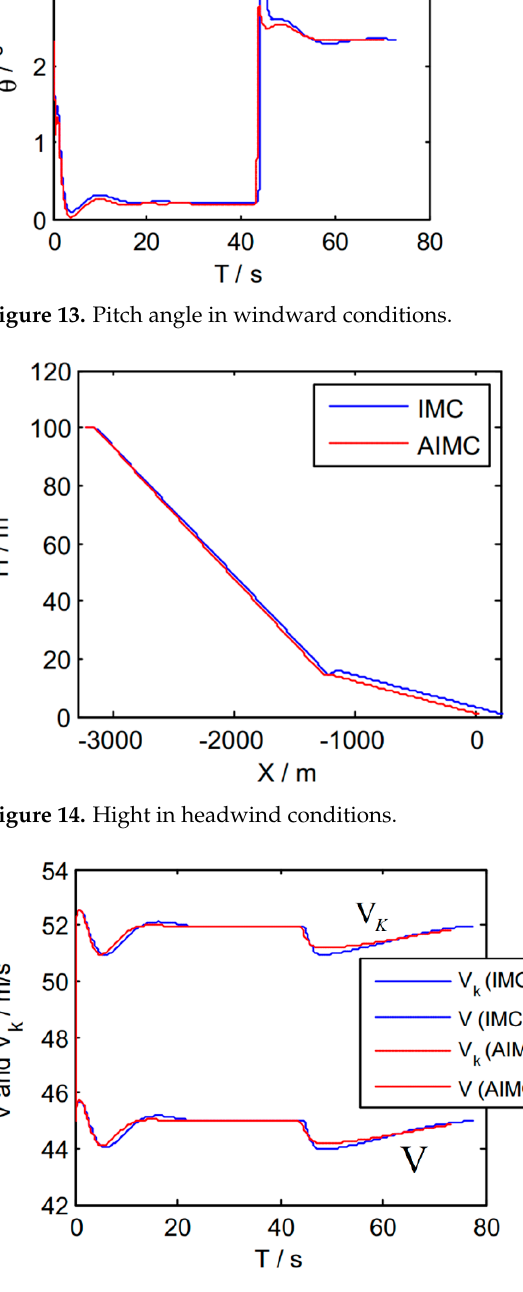
Figure 15. Air speed ( V k ) and grand speed ( V ) in headwind conditions.